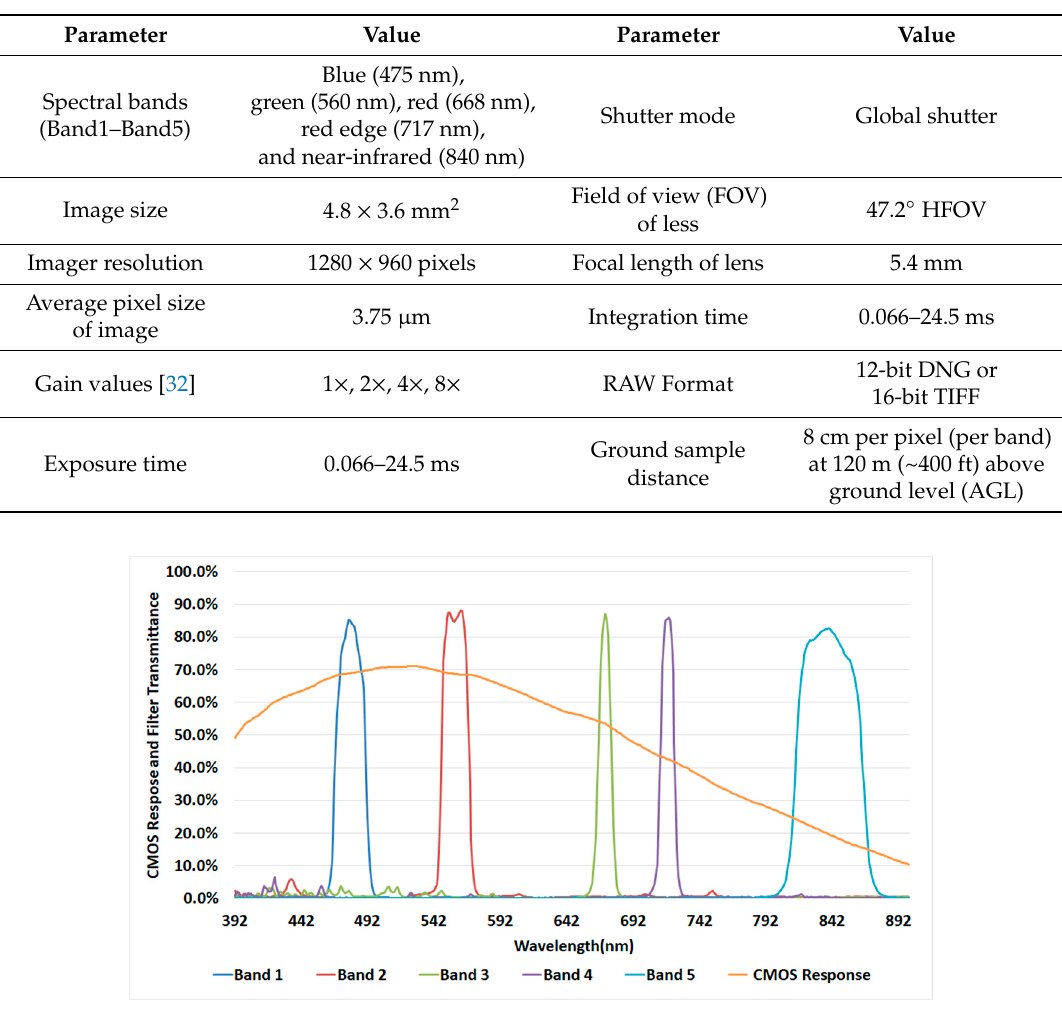
( b ) Figure 2. Integrating sphere system: ( a ) structure of integrating sphere system; ( b ) observation scheme of calibration. 2.2. Derivation of LUTs 2.2.1. Radiometric Calibration Model The DN recorded by the detectors of CMOS sensors looking at a target with emitting radiance 𝐿(𝑥, 𝑦) were modeled as follows [5,12–14,34]: